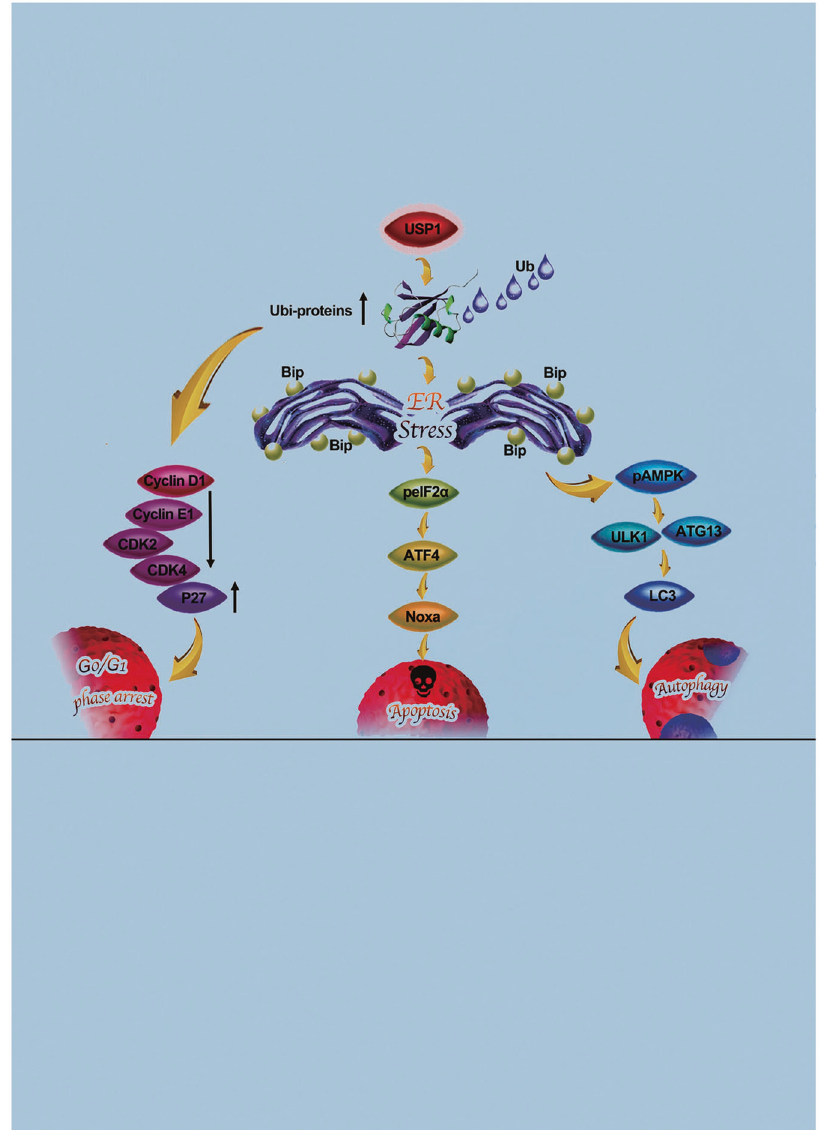
Fig. 9 This paper studies signal machine drawing. Schema of the mechanism for targeting USP1 induced cell cycle arrest, apoptosis and autophagy in